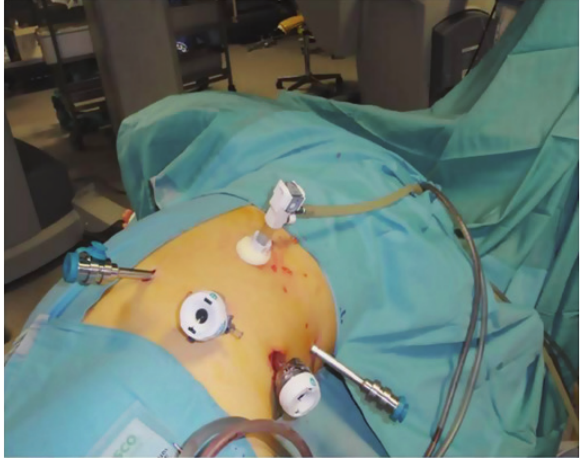
Figure 2 - Trocars positioned.